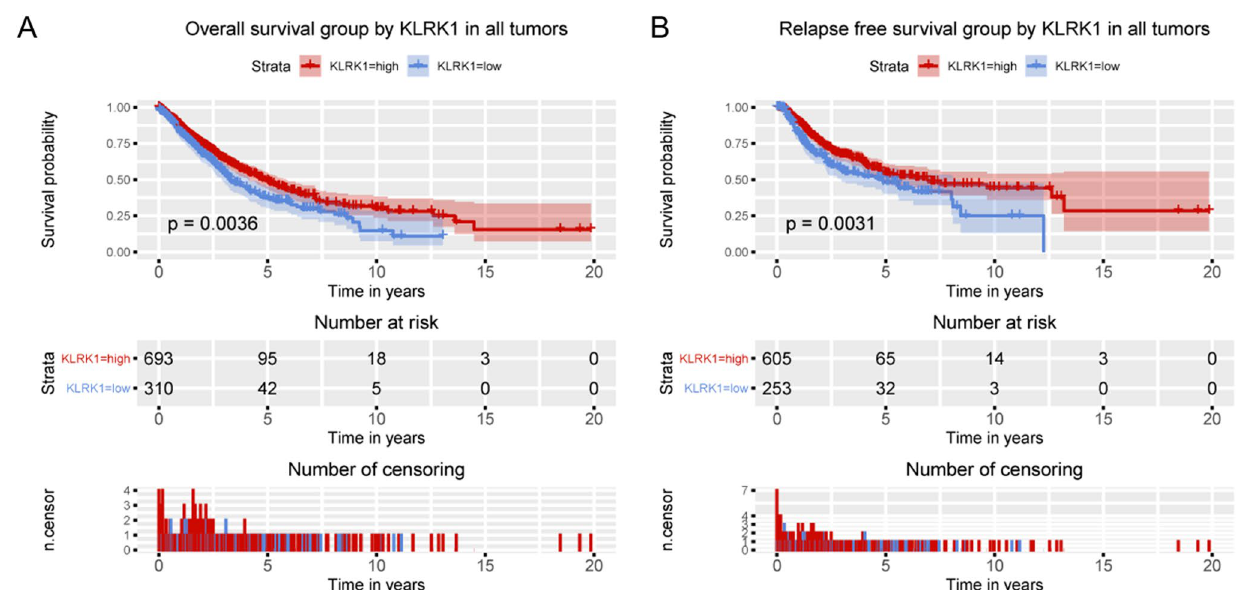
Figure 5. Relationship of KLRK1 expression with ( A ) overall and ( B ) relapse free survival in all patients with lung